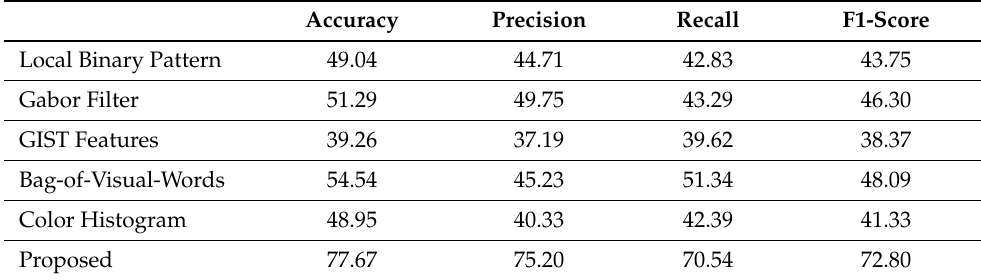
Table 2. Performance comparison of hand-crafted feature methods.